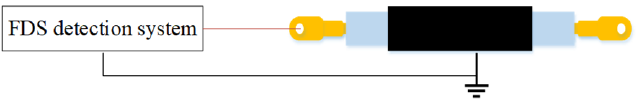
Figure 4. FDS measurement platform and connection diagram.